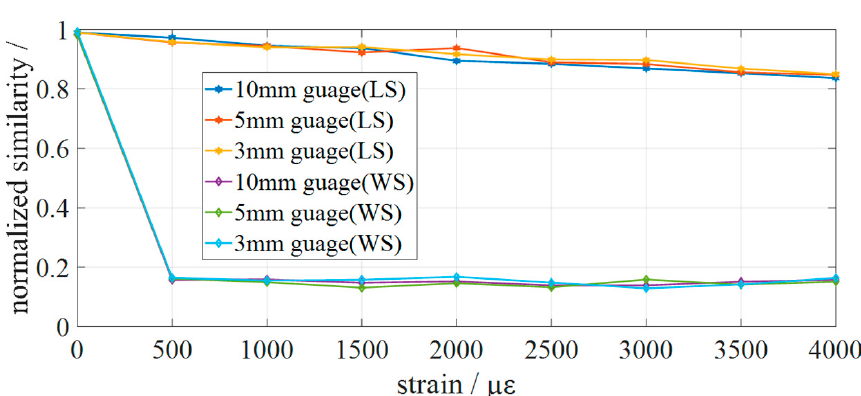
Figure 8. The demodulation results. The correlation coefficient between the measured spectrum and the reference spectrum of the traditional strain demodulation algorithm is reduced to less than 0.2 when the sensing fiber is 500 µε . The method proposed still maintains high spectral similarity when the sensing fiber is subjected to 4000 µε .